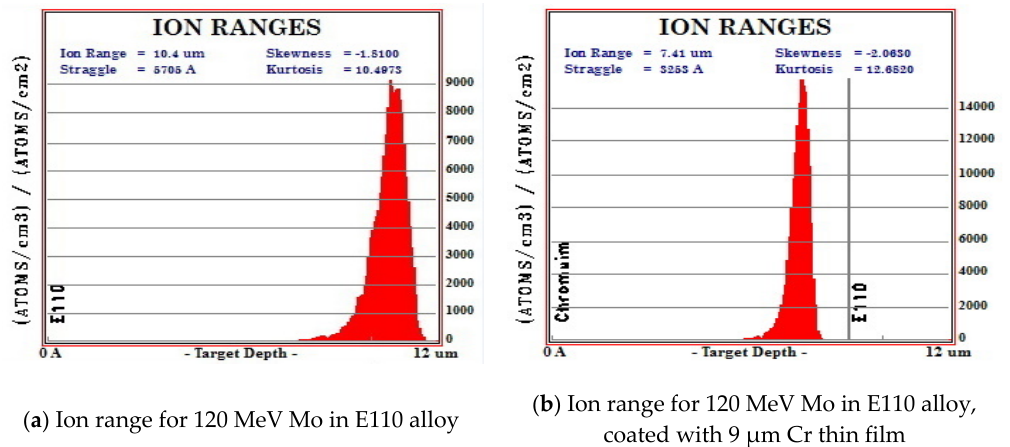
Figure 20. Ion ranges for 120 MeV Mo in: ( a ) Zirconium - based alloy, E110 ( b ) metallic